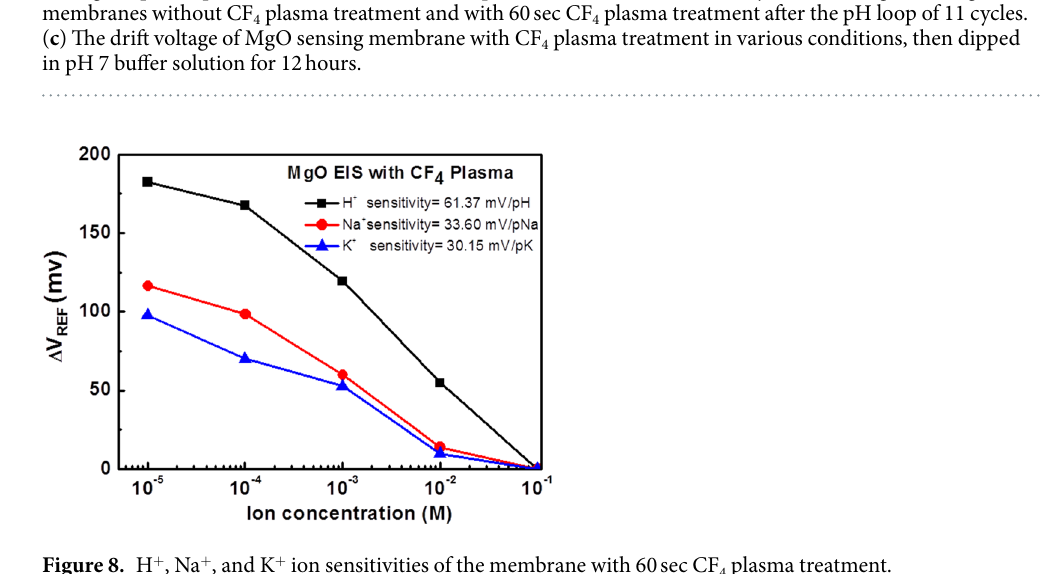
Figure 8. H + , Na + , and K + ion sensitivities of the membrane with 60 sec CF 4 plasma